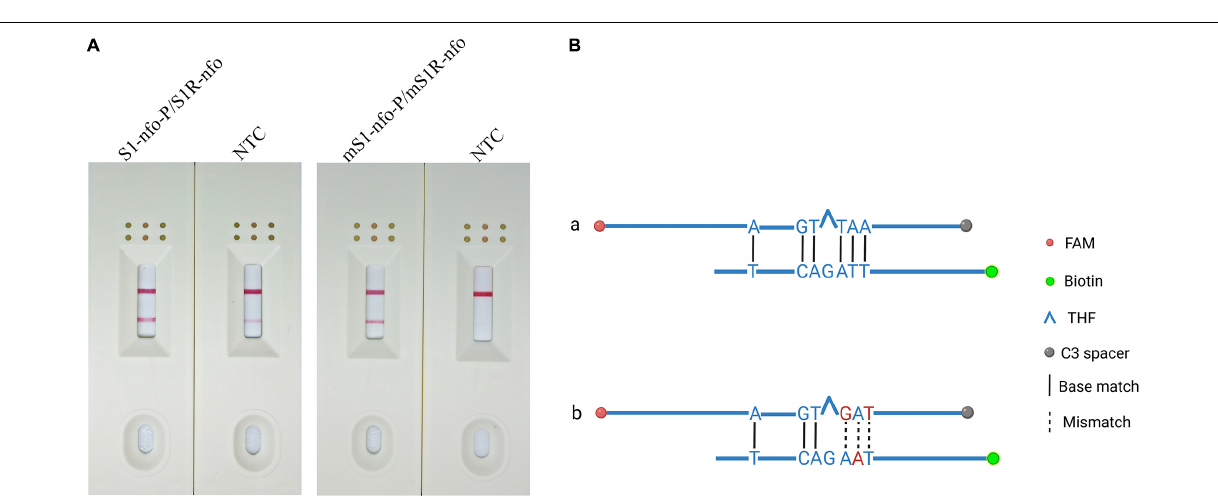
FIGURE 3 | Preliminary test and analysis of the original primer–probe set and base-substituted primer–probe set. (A) The image shows the LFD results for RPA amplifications using original primer–probe set and base-substituted primer–probe set. The name of each set is displayed above dipstick. NTC is no template control tested for false-positive signals. The positions of test and control lines are marked on the right of the dipsticks image. The template was B. xylophilus gDNA. The reactions are carried out at 38 ◦ C for 10 min. (B) Analysis of the cross-dimer formation between the probe and reverse primer. The original probe has five-continuous base pairings with original reverse primer, which could lead to primer–probe complex, resulting in a false positive signal. After bringing in mispairings into the original self-ligating primer–probe set, one of which is on reverse primer and two on the probe, the formation of the probe-primer complex is artificially interrupted and signal is eliminated. Labels and modifications for DNA, nfo, base matches, and mismatches are represented by different shapes and colors, and a legend is given to the right of the figure. Created with